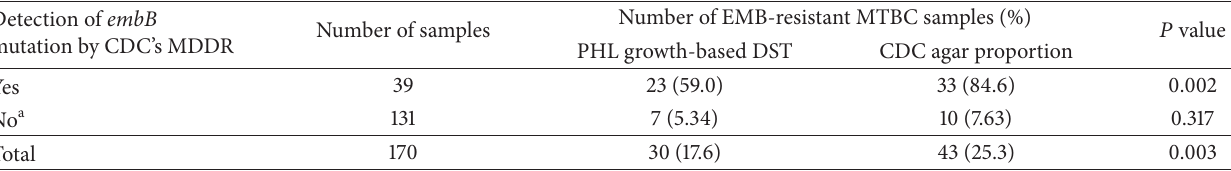
Table 2: Cross-tabulation of CDC’s molecular detection with both PHL and CDC growth-based DST results for determination of EMB